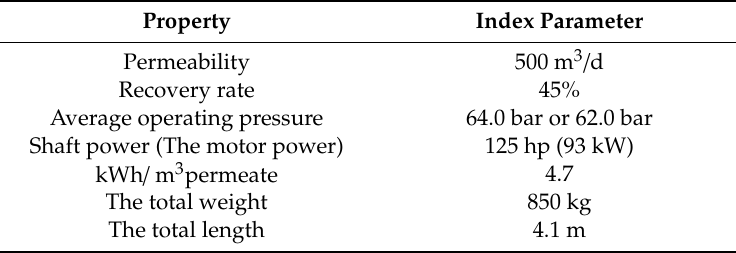
Table 8. A 150 ton / d example [8].